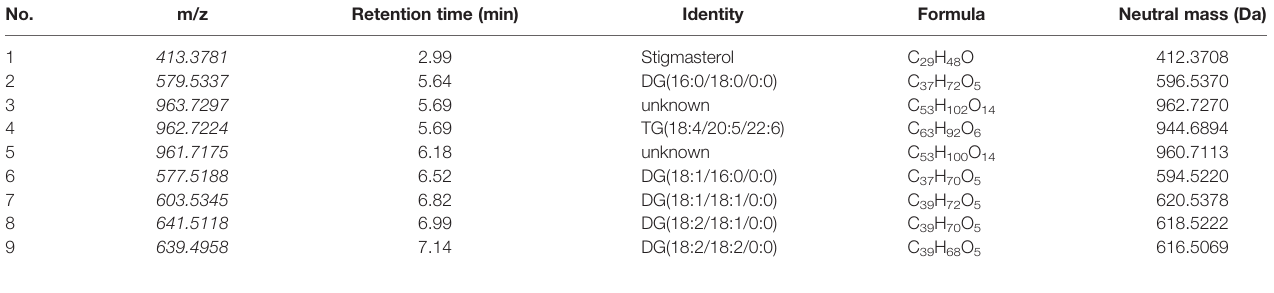
TABLE 3 | The identi fi ed results of nine differential markers between No. 190101 and No. 190105. No. Identity